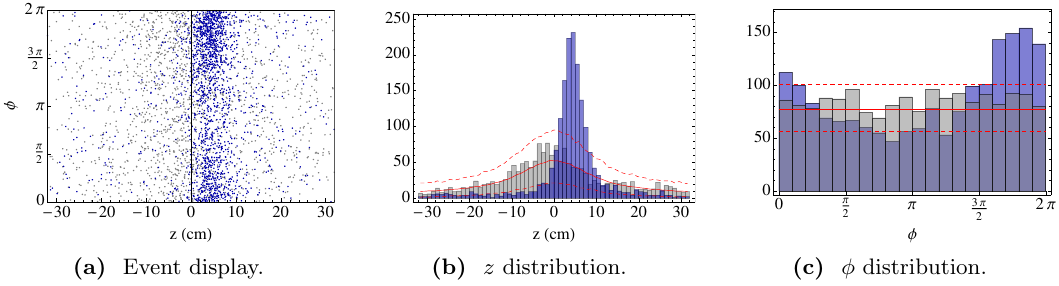
Figure 11. Distribution of the hits on the ATLAS IBL for an example signal event of the m S = 750 GeV benchmark. Hits from the primary vertex (pile-up) are marked in blue (gray). Solid (dashed) red lines indicate the bin-by-bin expectation value (99% interval) for pile-up only events.